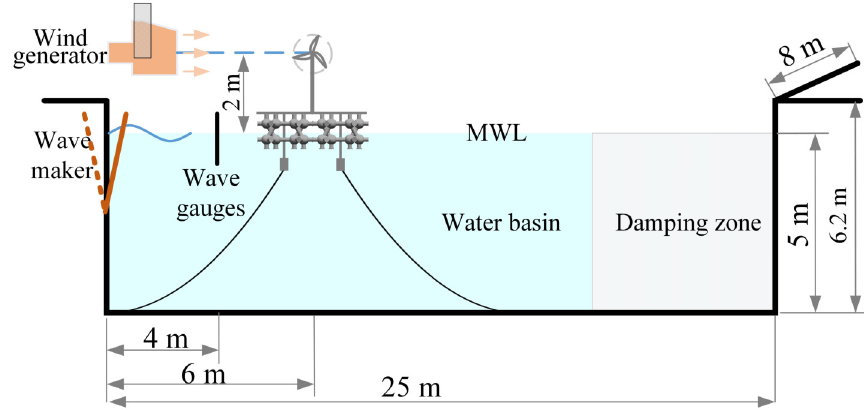
Figure 6. The layout diagram of the water